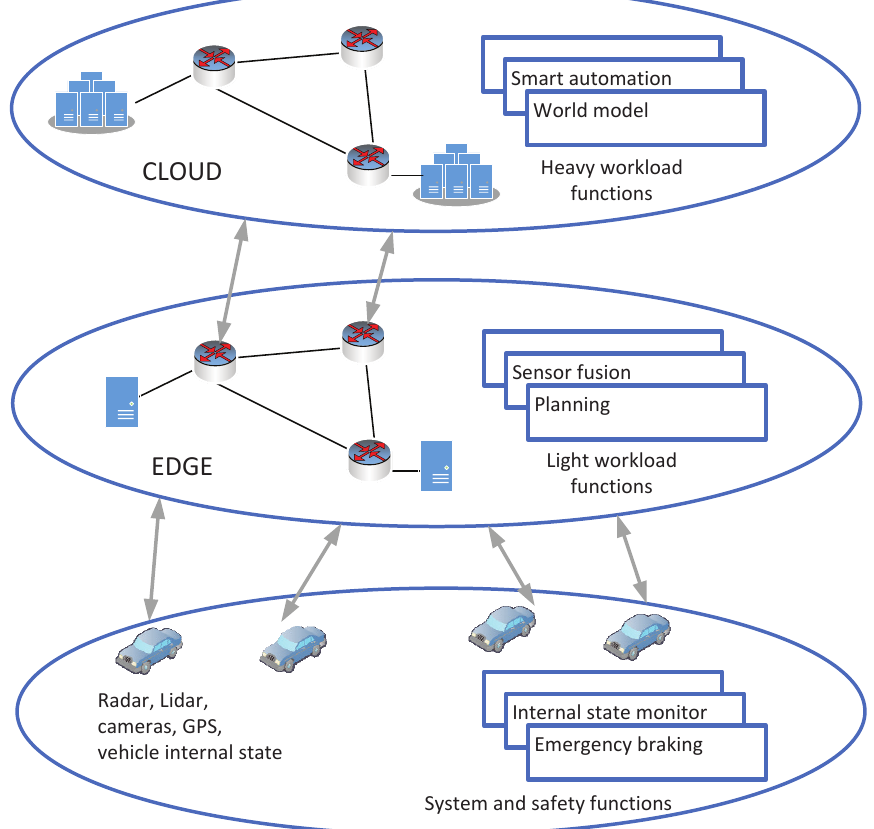
Figure 1. Functional components in an NFV-based connected autonomous